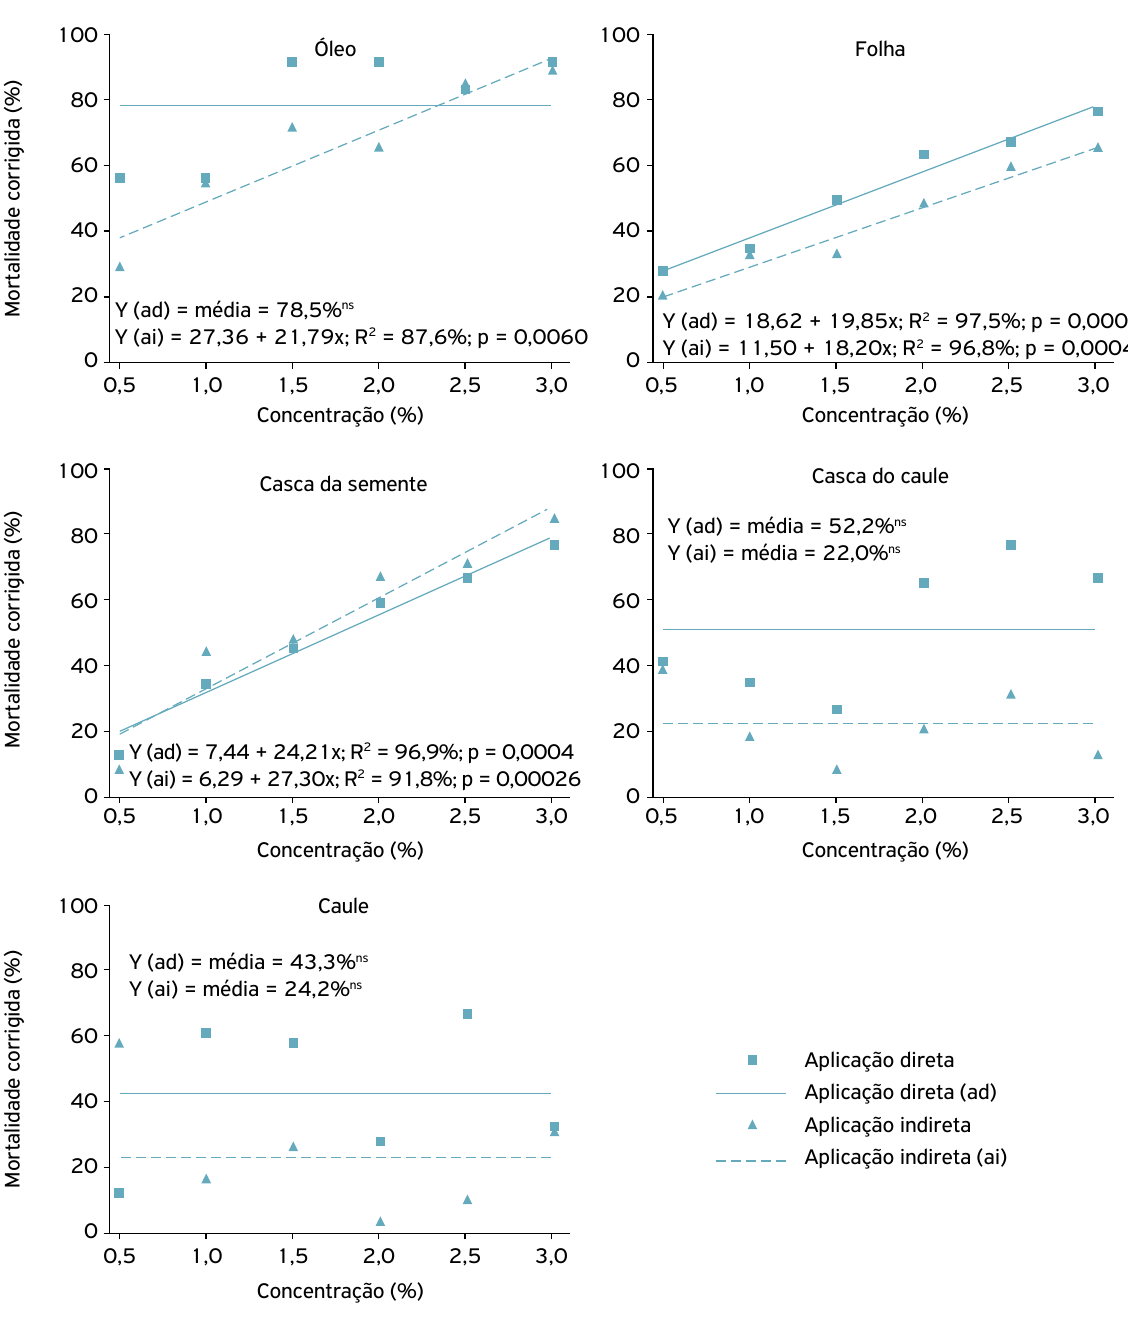
Figura 1. Mortalidade corrigida de Planococcus citri tratada com extratos de Jatropha curcas , a diferentes concentrações, pelas aplicações direta e indireta, após 72 h. Dados transformados para arc sen (x/100) 0,5